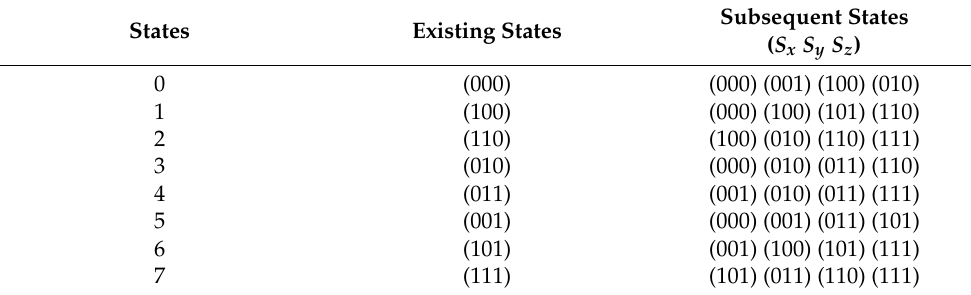
Table 2. Subsequent probable states for the proposed controller scheme.